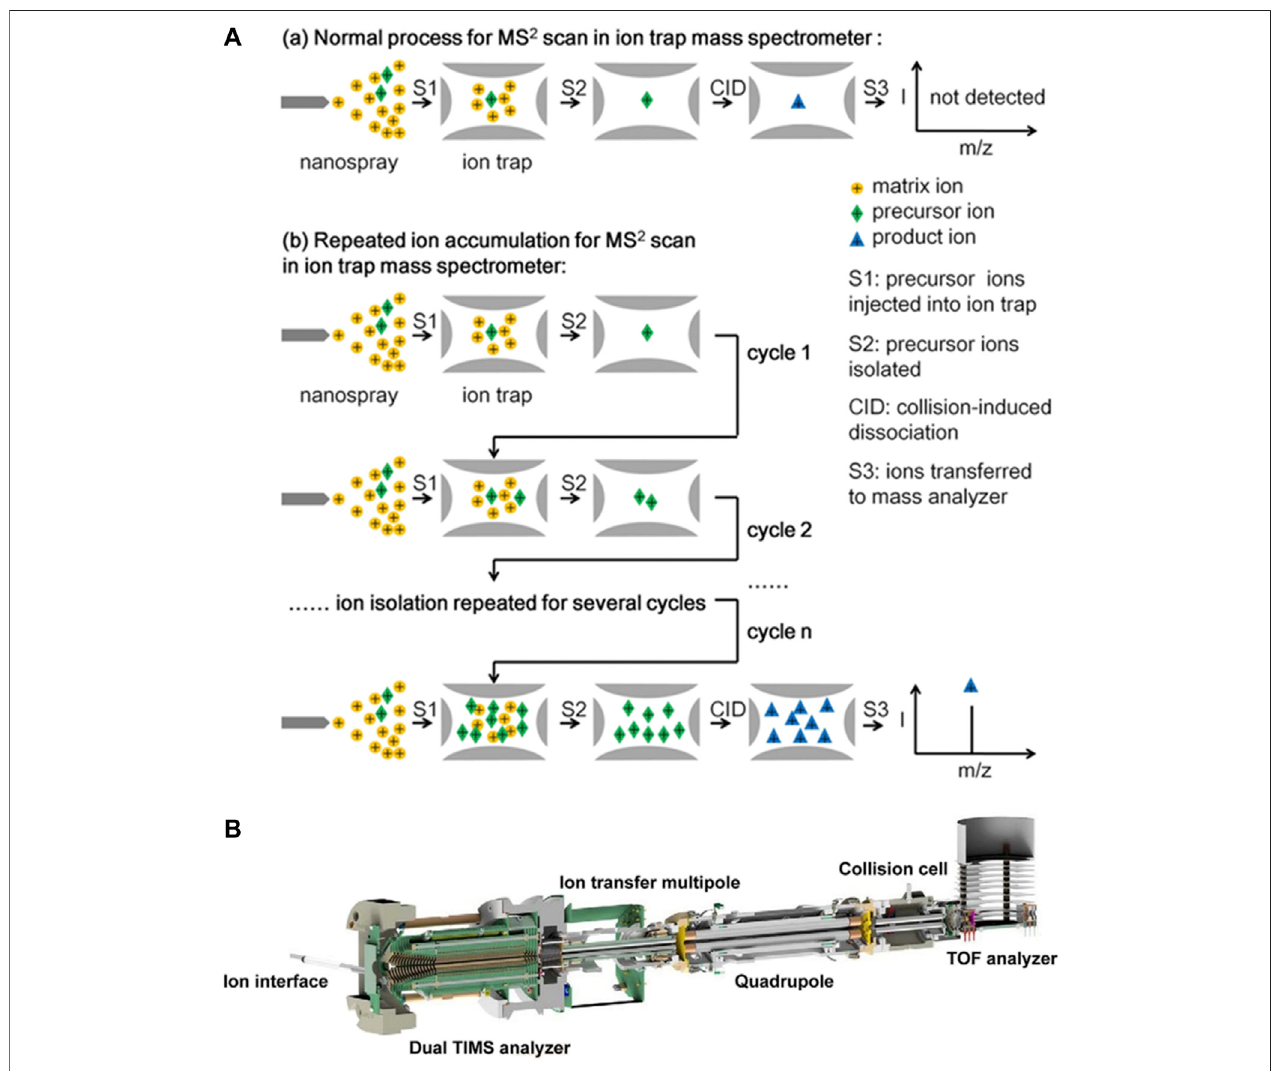
FIGURE 3 | (A) Normal procedure for MS 2 scan in ion trap mass spectrometer (a) and procedure of repeated ion accumulation by ion trap mass spectrometer (b). Adapted with permission from Si, X. Y., Xiong, X. C., Zhang, S. C., Fang, X. and Zhang, X. R. (2017). Anal. Chem. 89, 2,275 – 2,281 (Si, et al., 2017). Copyright 2017 American Chemical Society; (B) The dual TIMS and Q-TOF tandem mass spectrometer. Adapted with permission from Meier, F., Brunner, A.-D., Koch, S., Koch, H., Lubeck, M., Krause, M., et al. (2018). Mol. Cell. Proteomics 17, 2,534 – 2,545 (Meier et al., 2018). Copyright 2018 Elsevier.